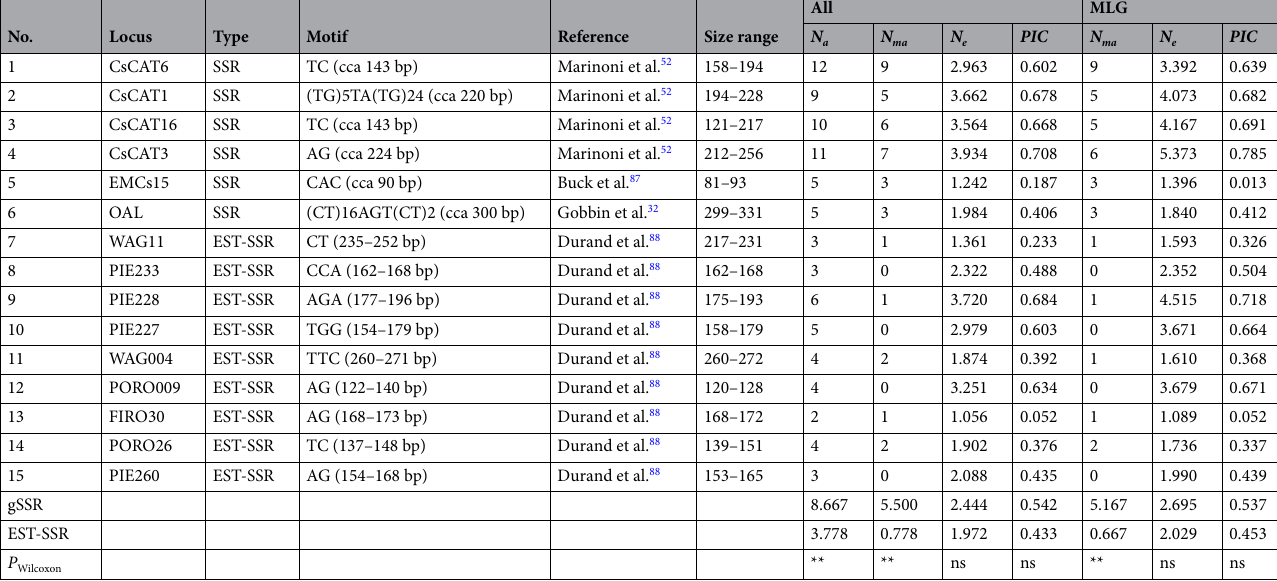
Table 1. Allelic diversity of six SSR loci and nine EST-SSRs for all individuals (ALL) and the non-redundant genotypes’ group (MLG). N